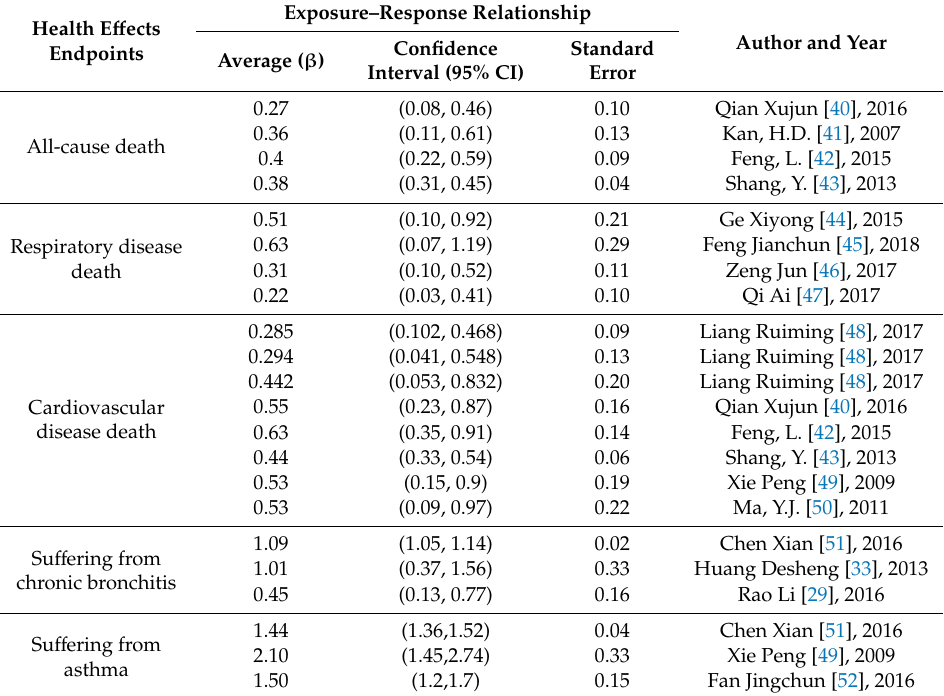
Table 2. Exposure–response relationship for each health-e ff ect endpoint.